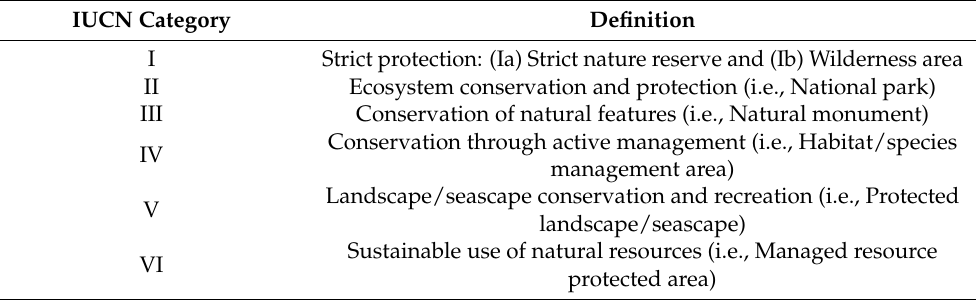
Table 1. IUCN categories of protected areas with definitions [14]. IUCN Category Definition I Strict protection: (Ia) Strict nature reserve and (Ib) Wilderness area II Ecosystem conservation and protection (i.e., National park) III Conservation of natural features (i.e., Natural monument) Conservation through active management (i.e., Habitat/species IV management area) Landscape/seascape conservation and recreation (i.e., Protected V landscape/seascape) Sustainable use of natural resources (i.e., Managed resource VI protected